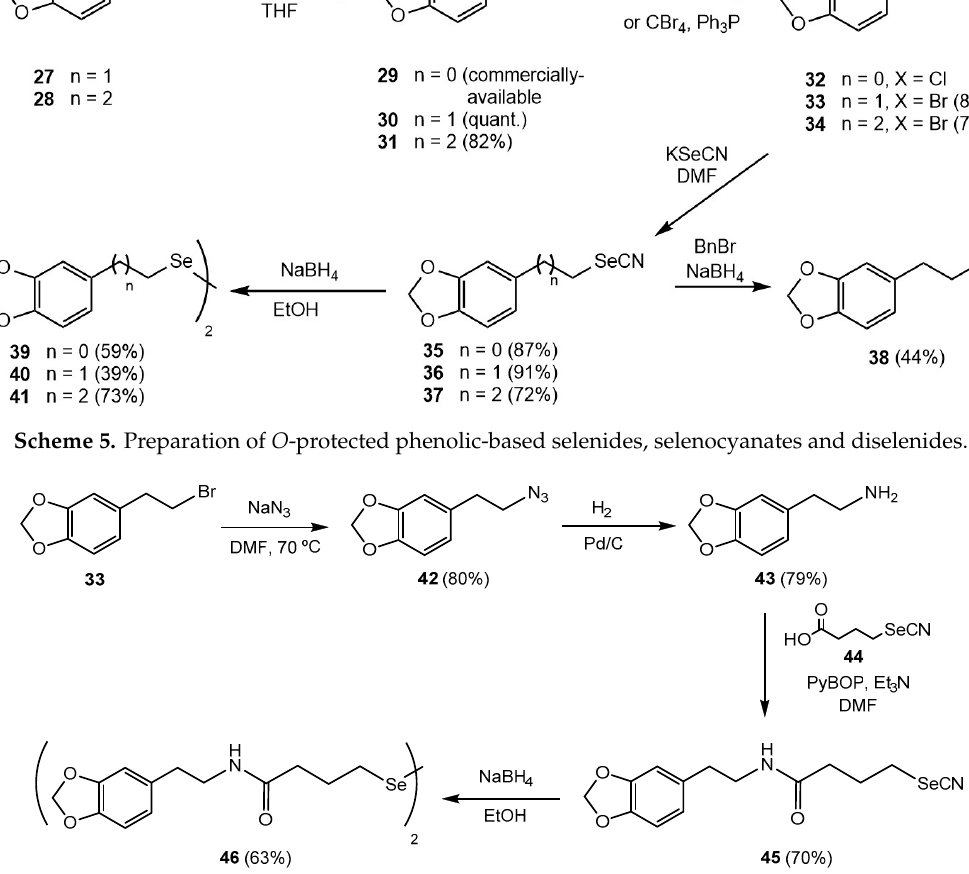
Scheme 5. Preparation of O -protected phenolic-based selenides, selenocyanates and